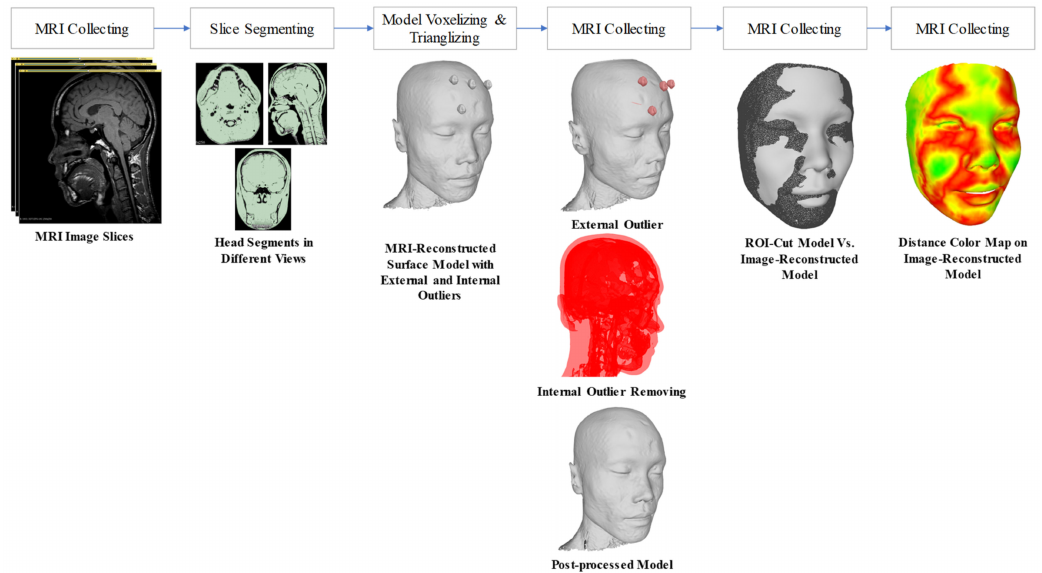
Figure 5. Reconstructed 3D face shape from the MRI images and segmentation. The 3D face shape was finally registered to the coordinate system of the image-based reconstructed face model before calculating the Hausdorff